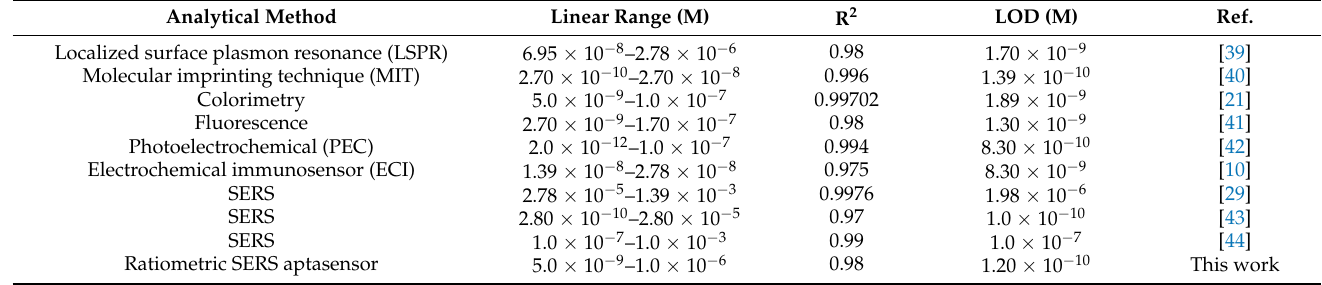
Table 1. Comparison of the established ratiometric SERS aptasensor with previously reported methods for enrofloxacin detection.